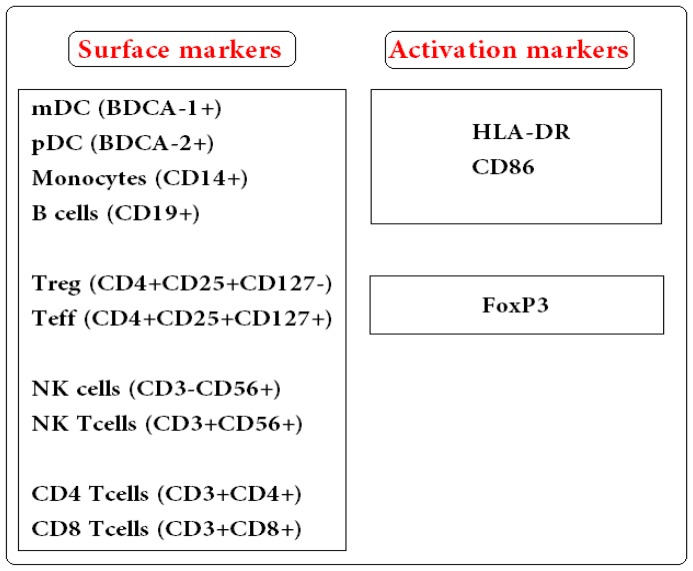
Basic flow cytometry-based phenotypic characterization of different cell populations investigated.The left panel lists the cell types identified with different surface markers and the right panel lists the separate markers used to characterize antigen-presenting cells activation status (HLA-DR & CD86) and to distinguish CD4+ regulatory T cells (Treg, expressing the transcription factor FoxP3) from effector T cells (Teff).